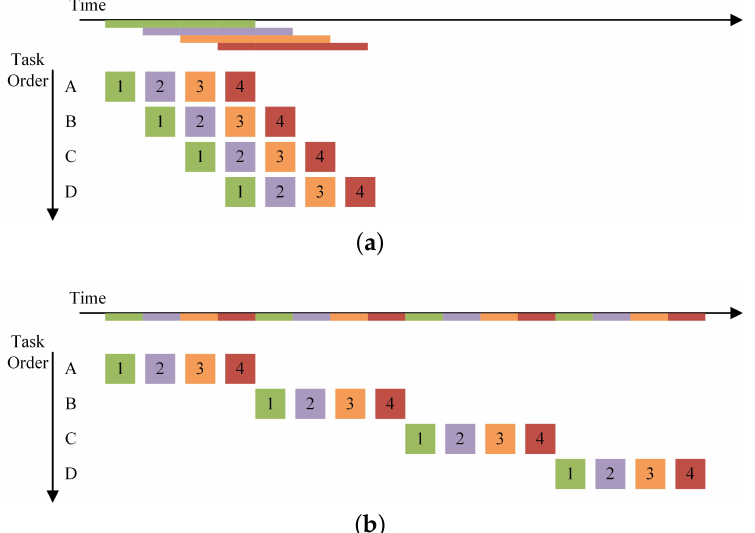
Figure 13. Types of processing architecture. ( a ) The pipeline architecture. ( b ) The instruction set